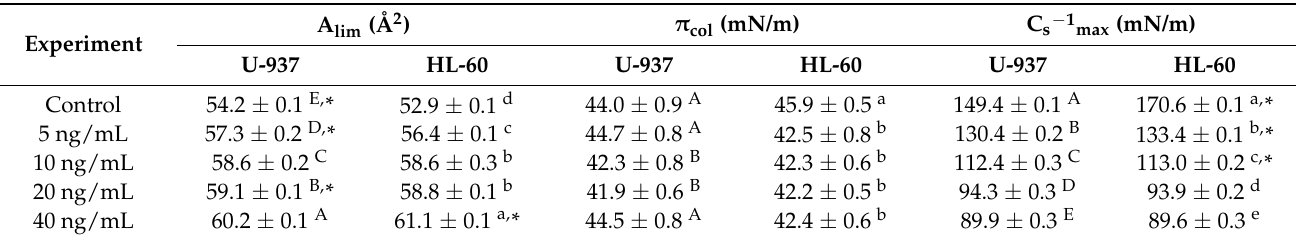
Table 1. Effect of four different 3FTx concentrations on parameters characterizing monolayers of model membrane sys- tems. Values represent the average ± SD (n = 5). Significant differences ( p ≤ 0.05) between model membranes systems are marked with an asterisk and between different 3FTx concentration: for U-937 cell line-uppercase letters, for HL-60 cell line-lowercase letters.